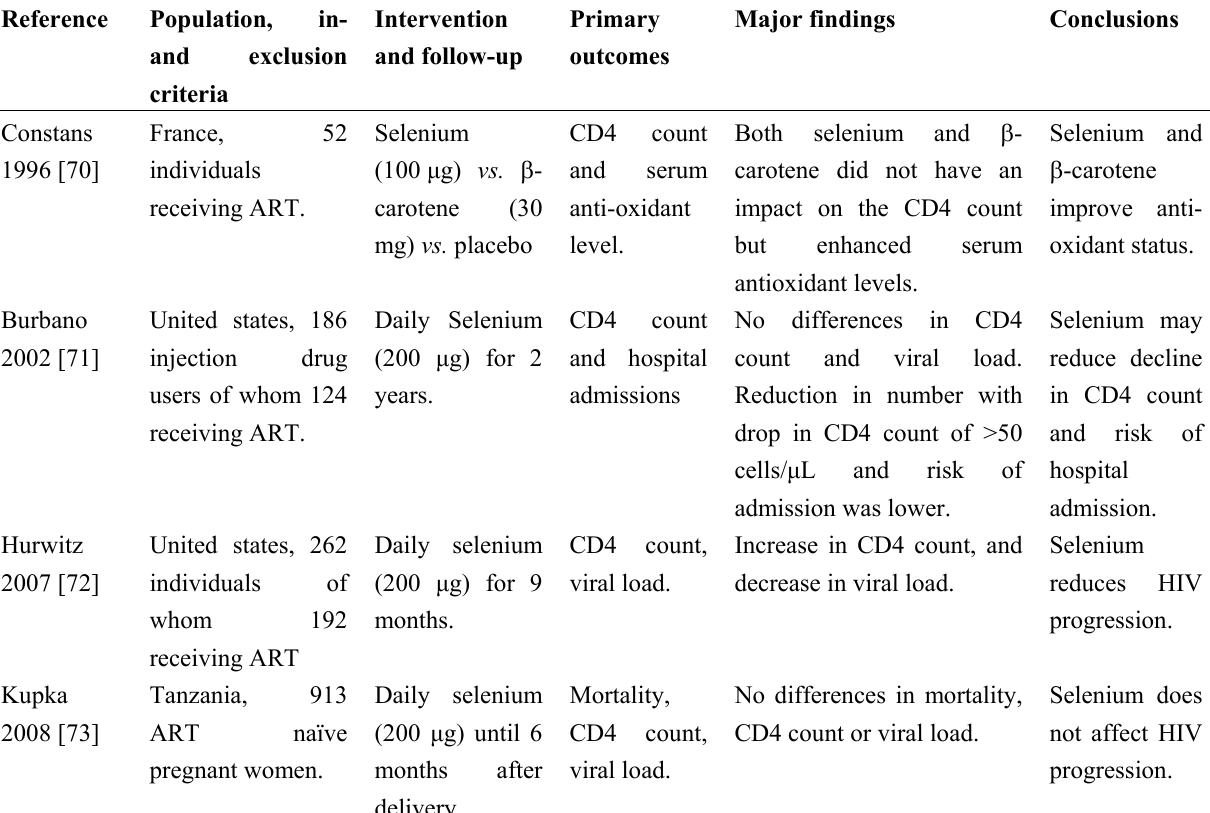
Table 5. Randomized, placebo controlled trials on selenium and HIV